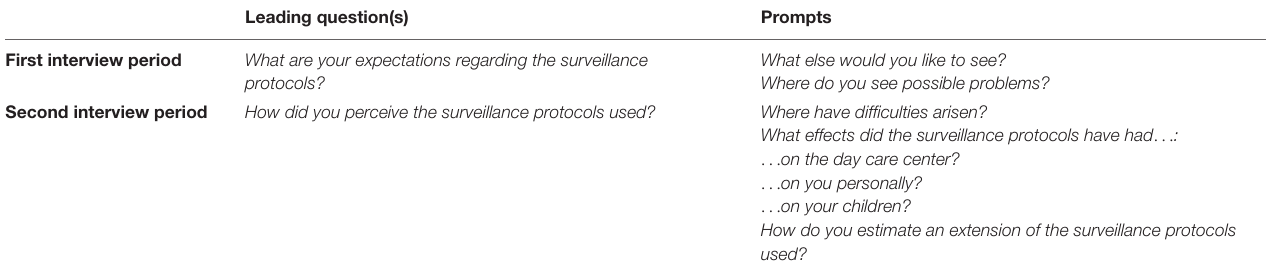
TABLE 1 | Leading questions and